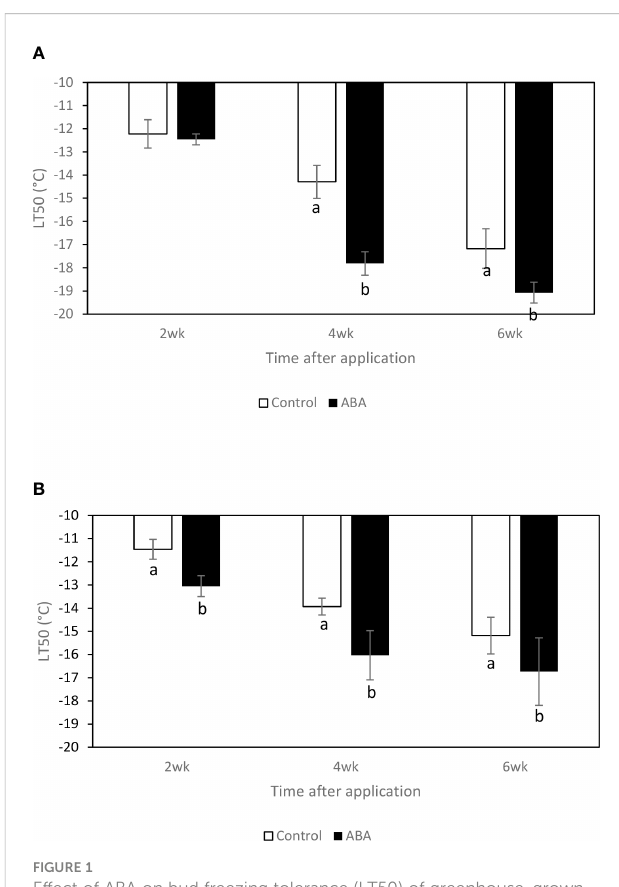
FIGURE 1 Effect of ABA on bud freezing tolerance (LT50) of greenhouse-grown grapevines, (A) ‘ Chambourcin ’ and (B) ‘ Cabernet franc ’ . Bars with different letters are signi fi cantly different at p ≤ 0.05. (n = 4). Standard errors are